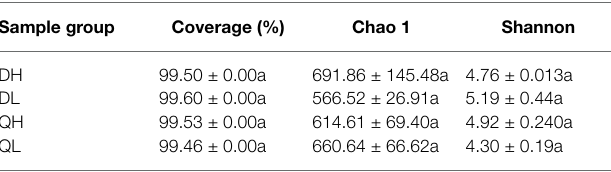
TABLE 1 | Root bacterial abundance and diversity of peach rootstocks under high P (HP) and low P (LP) conditions. Sample